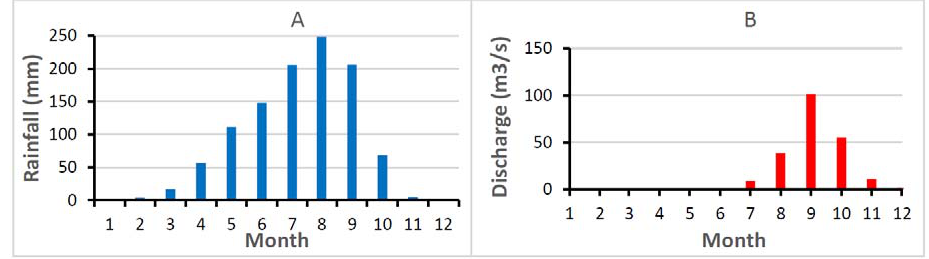
Figure 1. Seasonal variability of rainfall and discharge in the basin ( A : Monthly rainfall amounts over 1981–2014; B : Monthly mean of discharge over 2006–2012).